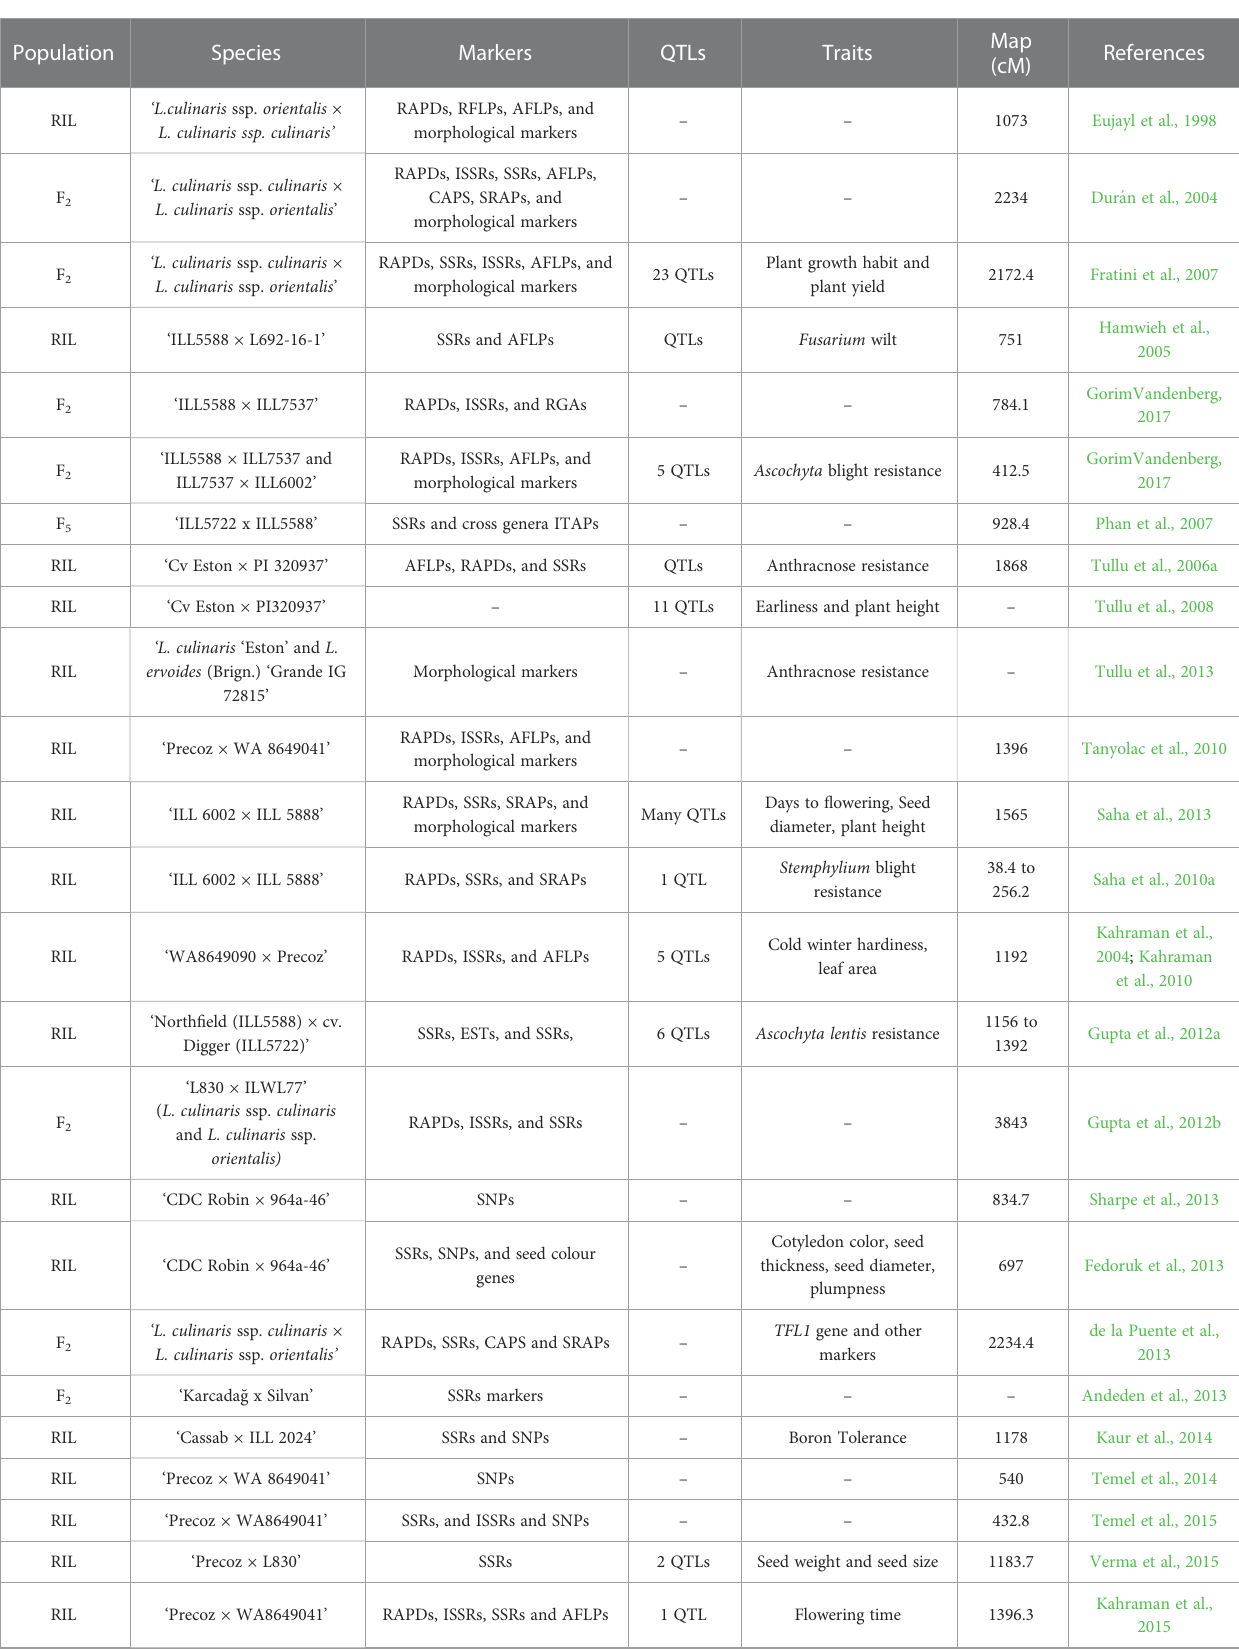
TABLE 3 Genetic linkage maps with QTLs/associated